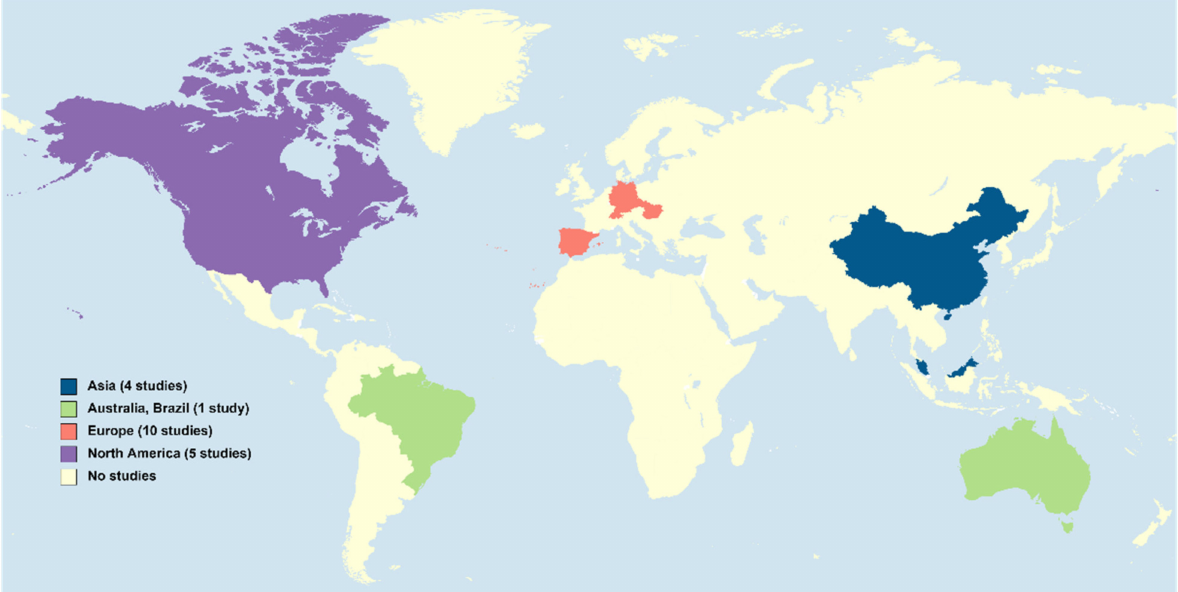
Figure 1. Locations in which studies on the levels of the synthetic PGs considered in this article were conducted in the aquatic environment from 2015 to 2021 (map generated from https://mapchart.net/ world.html, accessed on 27 December 2021).